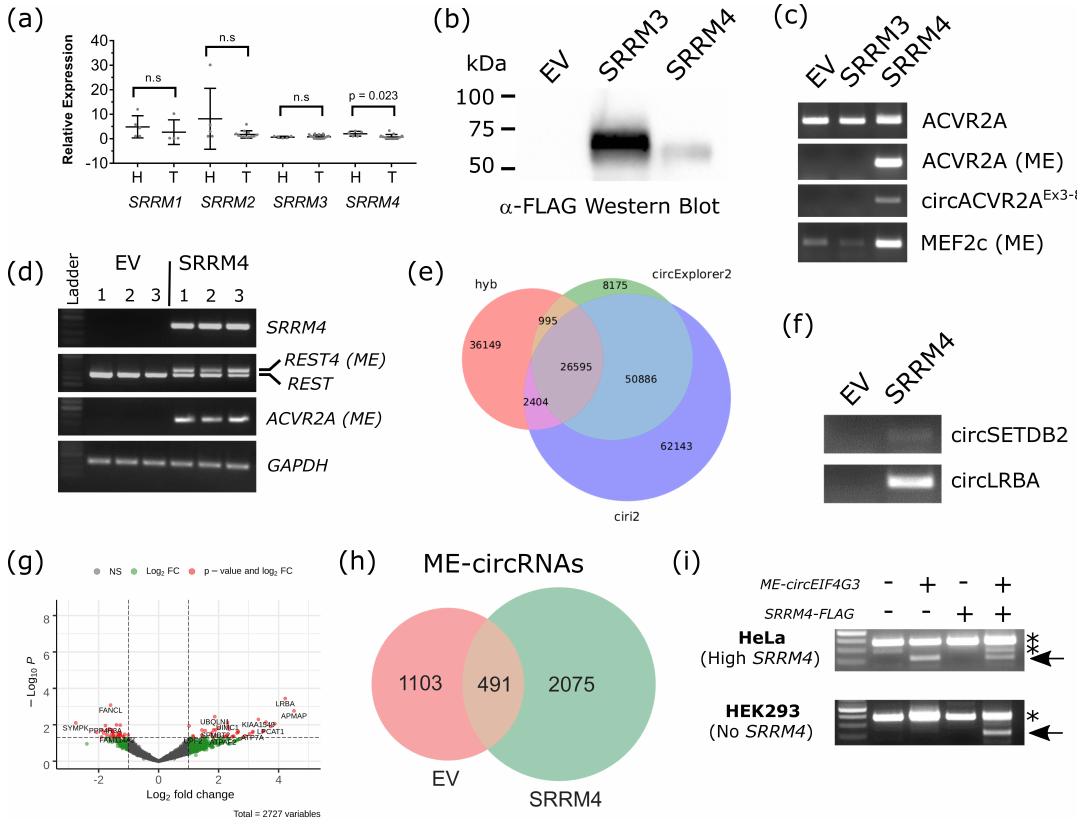
Figure 3. Serine / arginine repetitive matrix 4 (SRRM4) is a bona fide circRNA and ME-circRNA biogenesis factor. ( a ) qRT-PCR comparing relative expression of SRRM transcripts between healthy brain tissue (H) and GBM tumor tissue (T). Normalized to GAPDH, n = 4–5 tissue samples. One-way ANOVA, Mann–Whitney test was performed to assess significance. n.s.: no significant di ff erence ( p > 0.05) ( b ) Western blot using FLAG antibody on cell protein lysates from HEK293 cells transiently transfected with pcDNA3.1 (EV), pcDNA3.1::SRRM3-FLAG (SRRM3) or pcDNA3.1::SRRM4-FLAG (SRRM4). Bands of expected size for SRRM3 (70 kDa) and SRRM4 (65 kDa). ( c ) RT-PCR for ACVR2A linear (ACVR2A), and SRRM4-specific ACVR2A RNA with ME, circACVR2A (comprising exons 3-8) and increase in MEF2C linear RNA with ME. ( d ) RT-PCR on 3 biological replicates of HEK293 cells with EV, or SRRM4 overexpression for SRRM4 , REST (2 bands, with upper band representing the inclusion of ME in REST4 ), ACVR2A (ME) and GAPDH used as loading control. ( e ) Scaled Venn diagram showing total number of circRNAs identified across the three replicate EV and SRRM4 overexpression circRNA-seq libraries using three di ff erent circRNA identification pipelines, CIRCexplorer2, CIRI and Hyb. ( f ) RT-PCR for two novel SRRM4-driven circRNAs showing absence in HEK293 EV cells. ( g ) Volcano plot comparing circRNA expression between EV and SRRM4 overexpression. ( h ) Scaled Venn diagram showing ME-circRNAs, with the ME present at the backsplice junction, identified using Hyb. ( i ) RT-PCR showing the dependence on SRRM4 for expression of ME-circEIF4G3 from transgenic circRNA overexpression construct. Top, HeLa cells (with high levels of SRRM4 expression) could produce ME-circEIF4G3 with and without SRRM4 overexpression 24 h post-transfection. Bottom, HEK293 cells (lacking SRRM4 expression) could only produce the circRNA if SRRM4 was